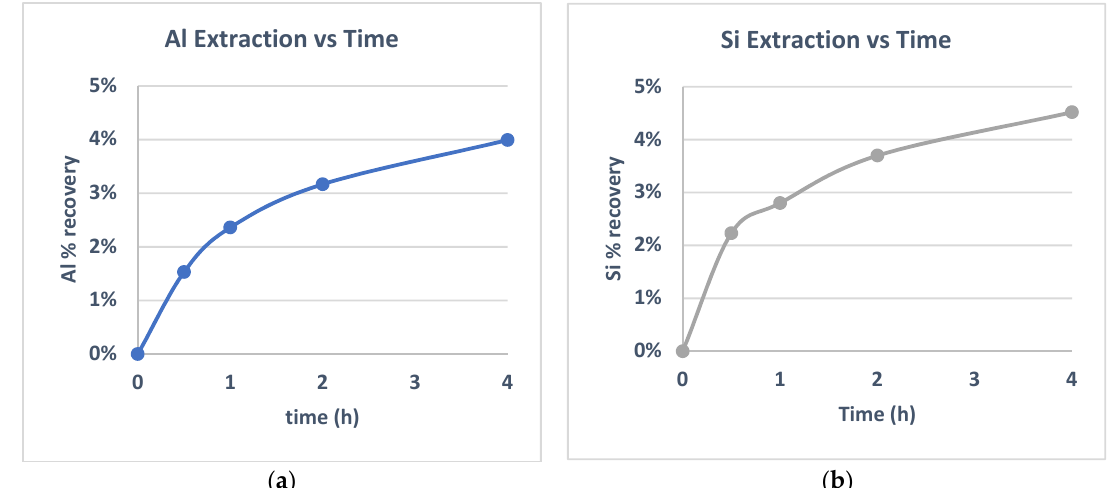
Figure 3. Effect of low molarity concentration of agent on the extraction of ( a ) Al, and ( b ) Si values from SB kaolin (stirring rate: 300 rpm, HCl concentration: 1 M, temperature: 90 °C, retention time: 4 h).